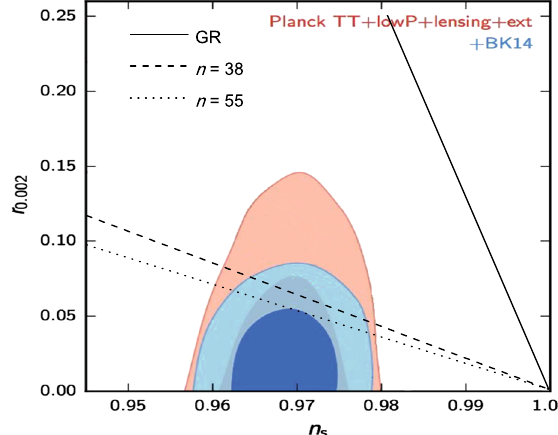
on the consistency relation r ( n s ) [22]. In both panels and from left to right, dotted and dashed and lines correspond to the cases where the power n takes the values n = 55 and n = 38, respectively. Finally, the solid line corresponds to the standard intermediate model. In these plots we have used f = 0 .